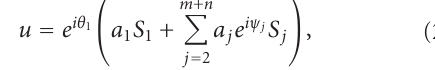
region with the first n modes from the double-pulse